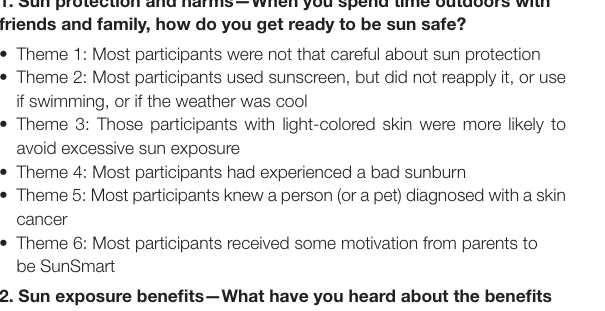
TABLE 2 | Discussion themes that emerged during Workshop